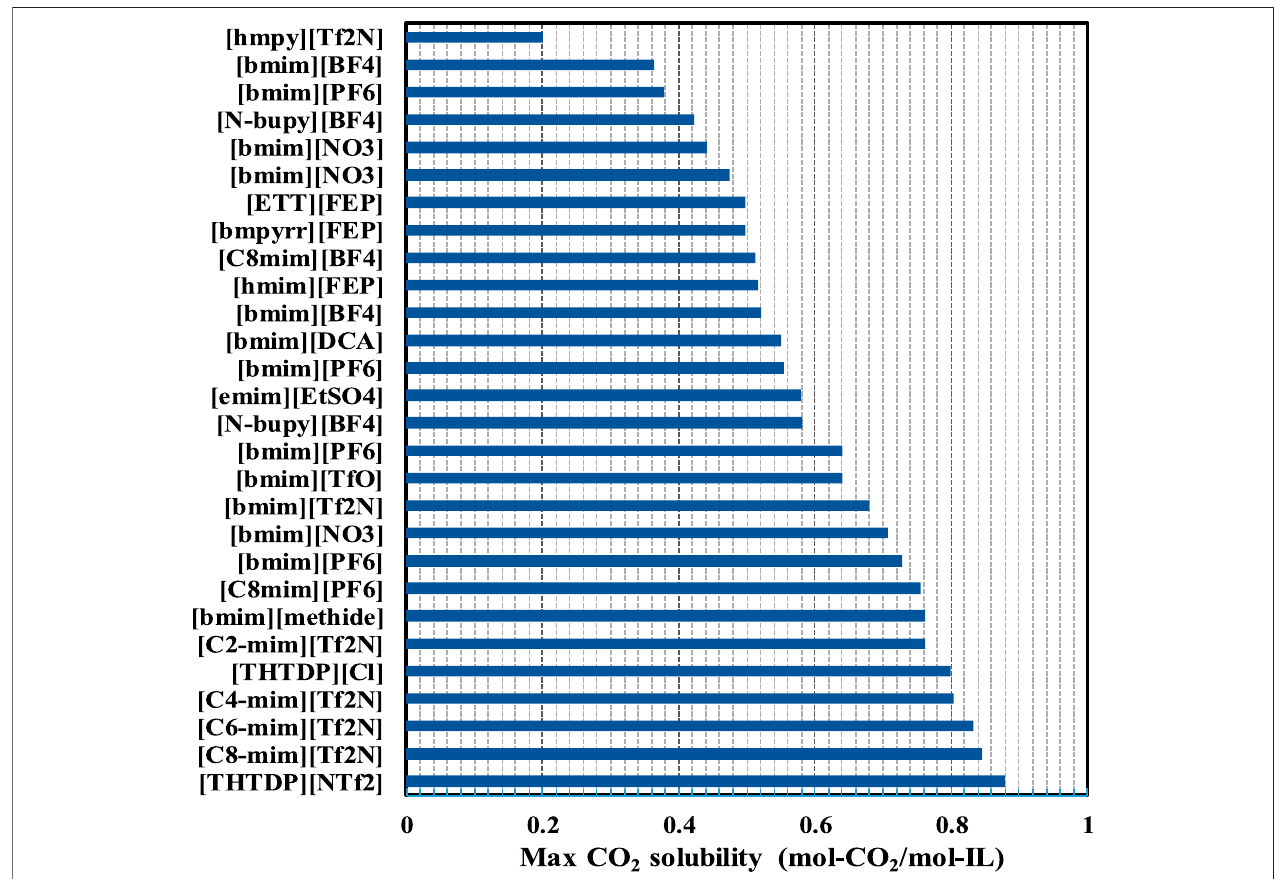
FIGURE 5 | The reported maximum CO 2 absorption capacity of some typical ionic liquids for CO 2 capture at 40 ° C with CO 2 partial pressure of 15 kPa, data from the literature (Zhang et al., 2008; Pérez-Salado Kamps et al., 2003; Shi fl ett and Yokozeki, 2005; Shin et al., 2008; Carvalho et al., 2010; Kilaru and Scovazzo, 2008; Anderson et al., 2007; Aki et al., 2004; Blanchard et al.,